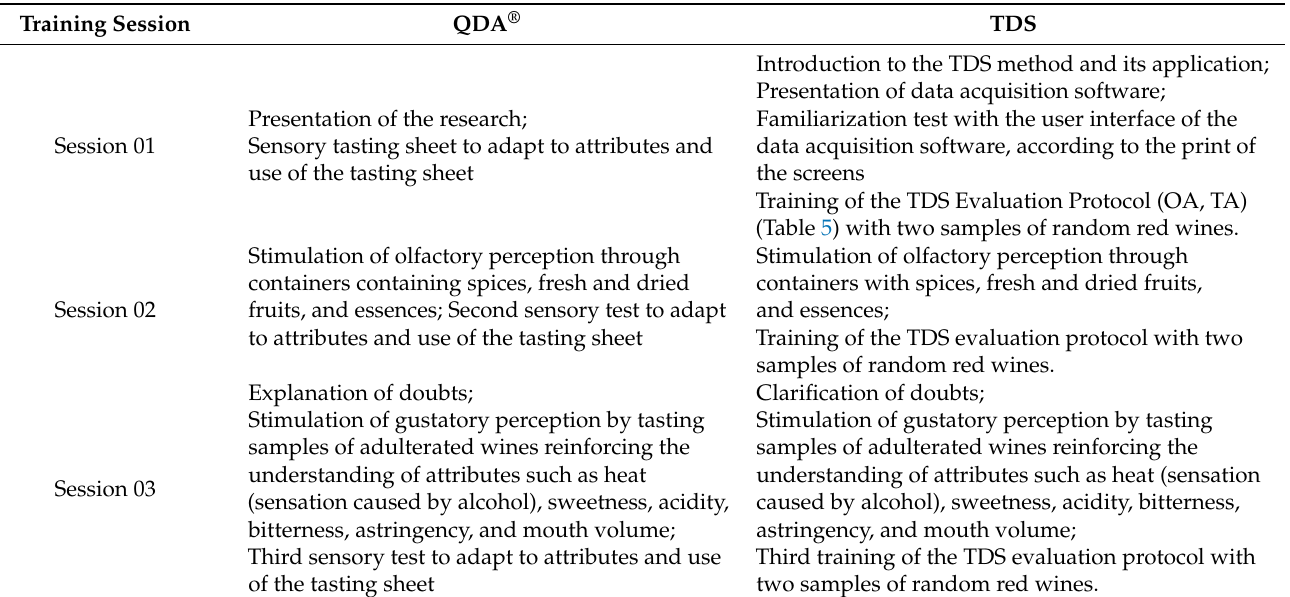
Table 4. Diagram of the content explained in the training sessions for the application of the QDA ® and TDS